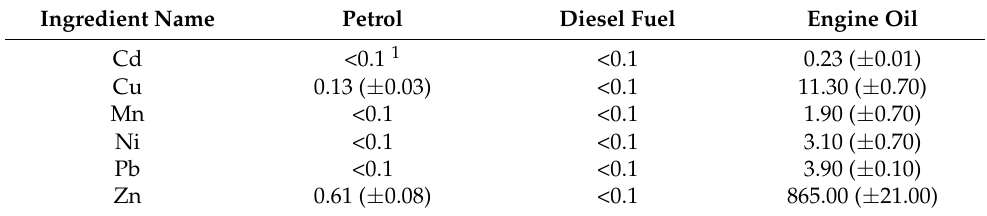
Table 2. The content of heavy metals in the PDSs that were used in the experiment (mg kg − 1 ) as means ( ± SD).